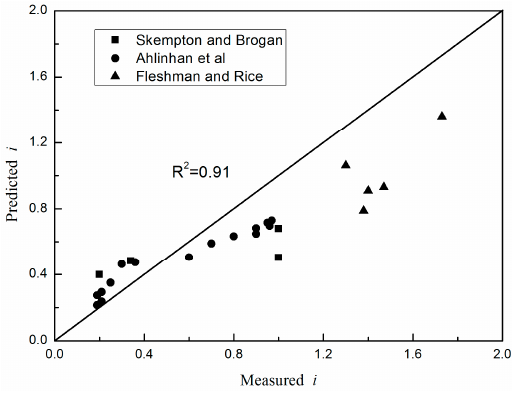
Figure 7. Comparison between predicted and measured data for an upward seepage. Table 2. Predicted and measured i in the analyzed experiments.